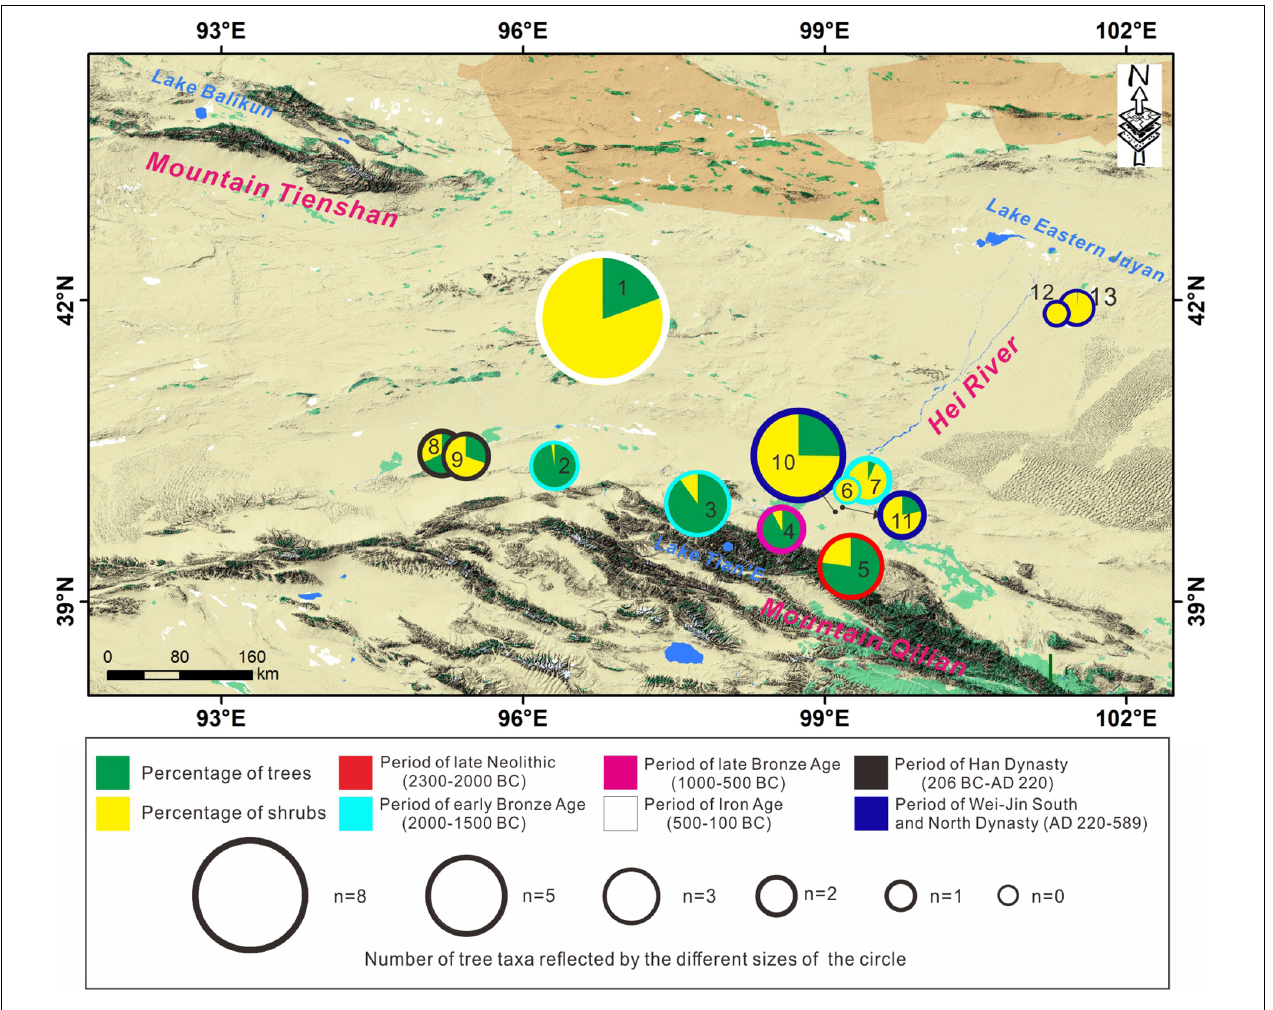
FIGURE 7 | Comparison of the uses of wood at JBR and archeological sites in the western Hexi Corridor, including percentages of trees and shrubs as well as the number of arboreal taxa identified in archeological sites. Varying sizes of circles reflect the number of arboreal taxa identified at each site, and “n” represents the number of tree species identified. The Arabic numerals in the circles represent the relevant archeological site: (1) JBR jade mine. (2) Yingwushu. (3) Huoshaogou. (4) Zhaojiashuimo. (5) Xihetan. (6) Ganggangwa. (7) Huoshiliang. (8) Lucaogou 1. (9) Lucaogou 2. (10) Huishui. (11) Xisanjiao. (12) K749. (13)